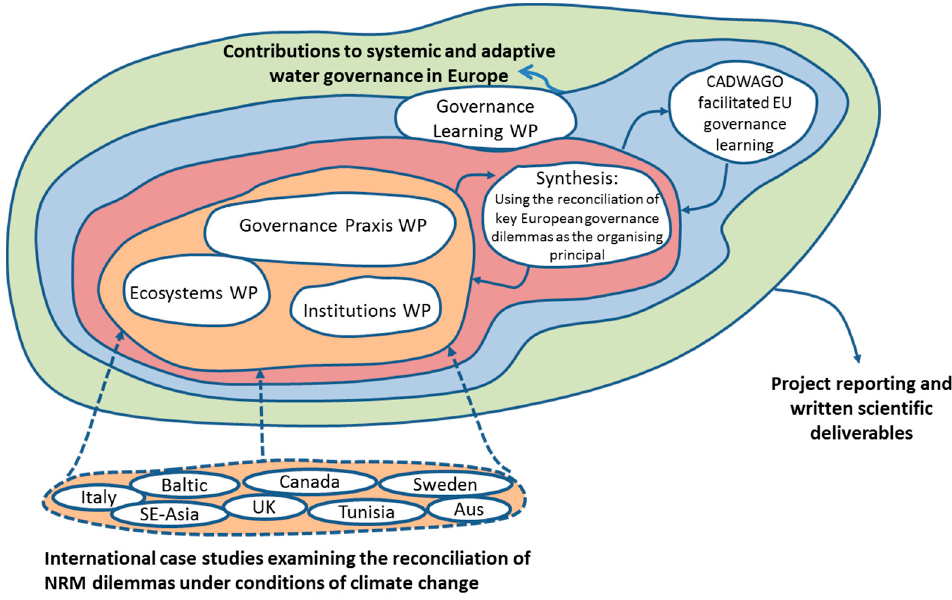
Figure 1. The climate change adaptation and water governance project (CADWAGO) research process. (Source: [7]) WP: ‘work packages’.